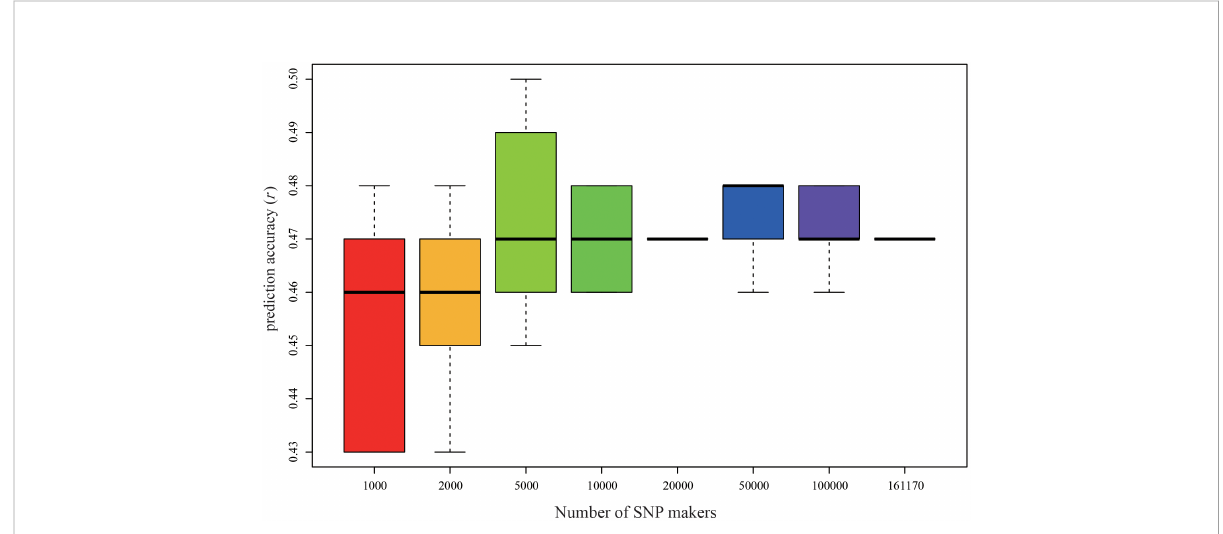
FIGURE 8 Genomic prediction accuracy of biomass yield at Tongzhou in P149 using different levels of marker datasets by rrBLUP. rrBLUP, ridge-regression best linear unbiased